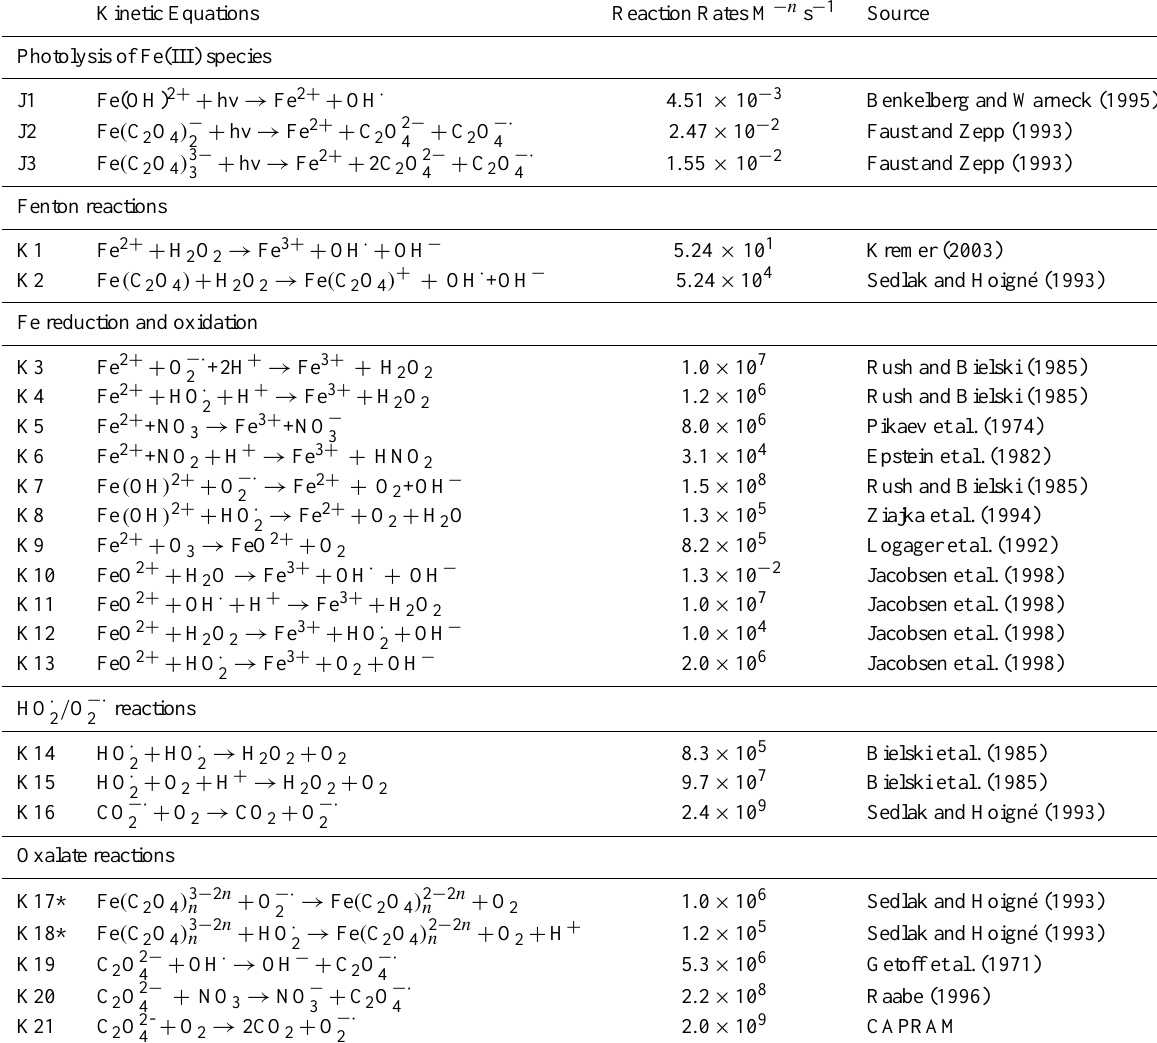
Table 3. Kinetic and photochemical reactions implemented into SMVGEAR II. Kinetic